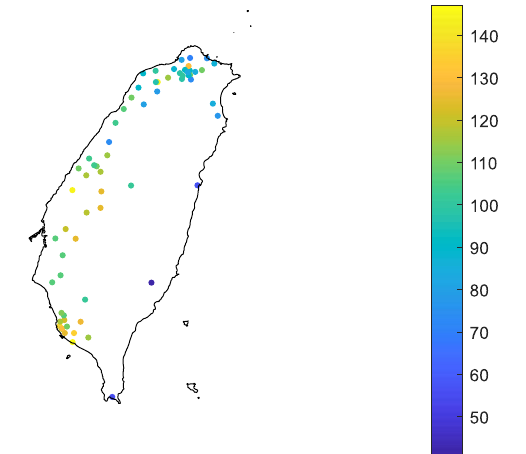
Figure 2. Average extreme PM 2.5 concentration within 96 h from 2005 to 2015 (unit: μg/m 3 ).